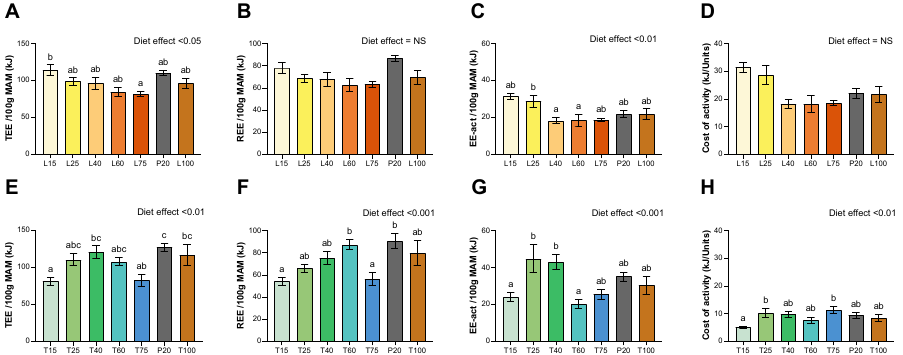
Figure 2. Total energy expenditure (TEE), resting energy expenditure (REE), activity energy expenditure (EE-act) and cost of activity, as obtained by indirect calorimetry. ( A – D ) Under lysine diets. ( E – H ) Under threonine diets. Values are expressed as means + SEM. Data that do not share the same letter are different at p < 0.05.